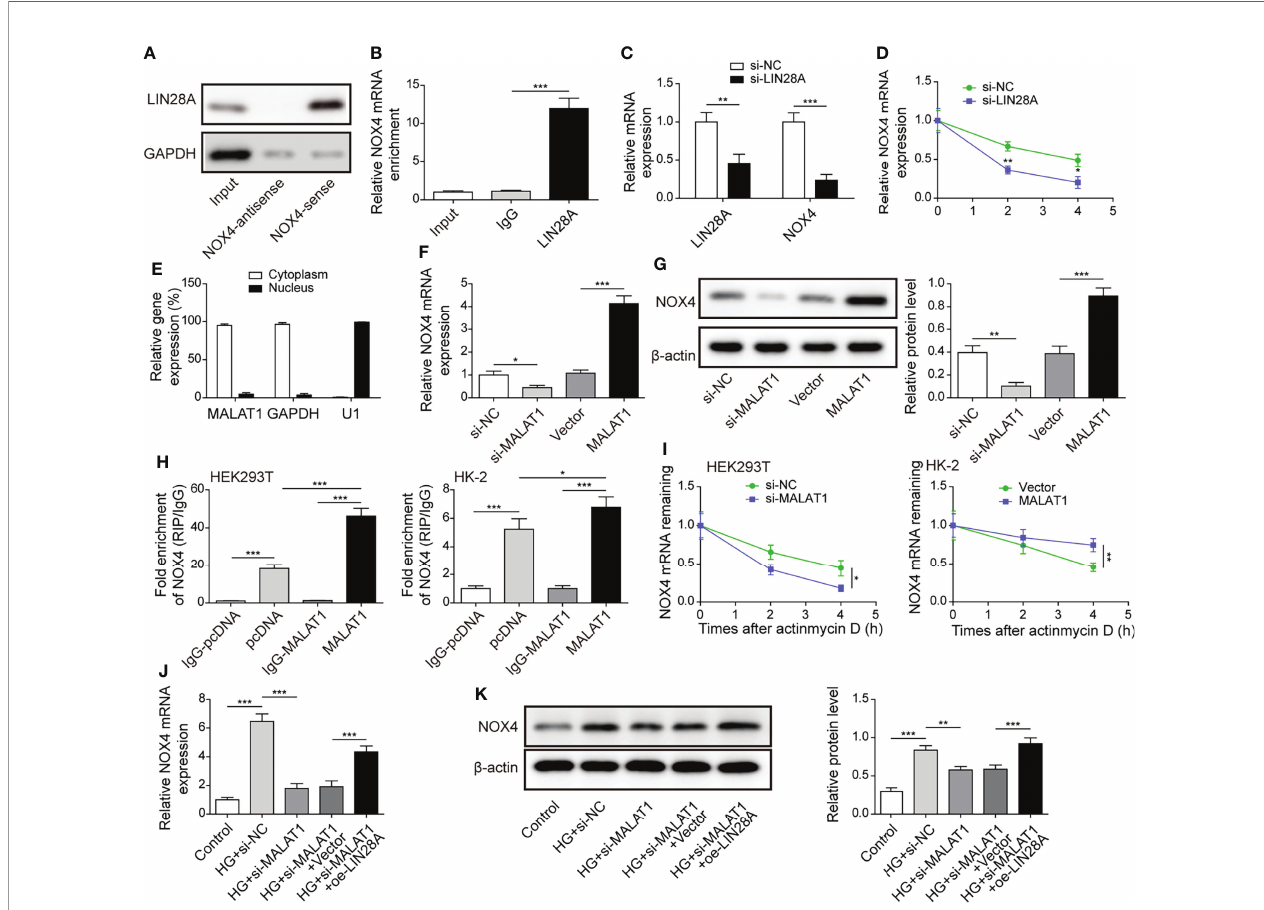
FIGURE 5 | MALAT1 facilitated the interaction of LIN28A and Nox4 to stabilize Nox4 mRNA in HK-2 cells. (A) LIN28A was pulled down by the Nox4 sense probe (n=3). (B) The enrichment of Nox4 in anti-LIN28A-immunoprecipitated fractions from HK-2 cells was analyzed by qRT-PCR (n=3). (C) Levels of LIN28A and Nox4 mRNA in HK-2 cells transfected with si-NC or si-LIN28A (n=4). (D) Nox4 mRNA stability in response to actinomycin D was determined by qRT-PCR (n=3). (E) The abundance of MALAT1, GAPDH and U1 snRNA in cytoplastic and nuclear fractions (n=4). The expression of Nox4 was analyzed by qRT-PCR (F, n=4) and western blotting ( G , n=4). (H) RIP assays for analyzing the interaction between LIN28A and Nox4 in HK-2 and HEK-293T cells (n=3). (I) Nox4 mRNA stability in response to actinomycin D was determined by qRT-PCR in HK-2 and HEK-293T cells (n=3). HK-2 cells were transfected with si-NC, si-MALAT1, si-MALAT1 + vector or si- MALAT1 + oe-LIN28A and subsequently treated with HG for 48 h The expression of Nox4 was determined by qRT-PCR ( J , n=4) and western blotting ( K , n=4). * P < 0.05, ** P < 0.01 and *** P <